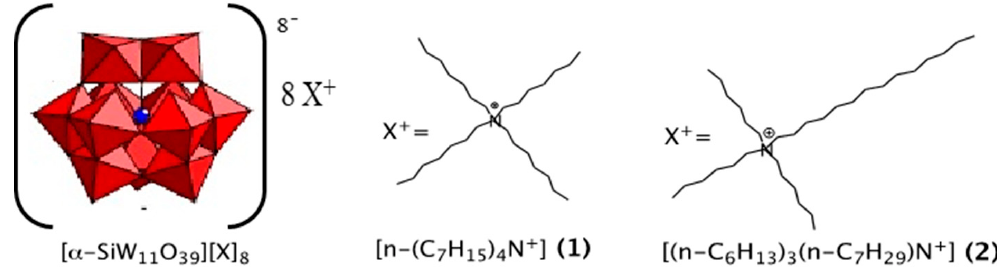
Figure 7. Schematic representation of the two POM-ILs, namely [(n-C 7 H 15 ) 4 N] 8 [ α -SiW 11 O 39 ] ( 1 ) and [(n-C 6 H 13 ) 3 [(n-C 14 H 29 )N] 8 [ α -SiW 11 O 39 ] ( 2 ), investigated both as antimicrobial and anticorrosive stone coatings.